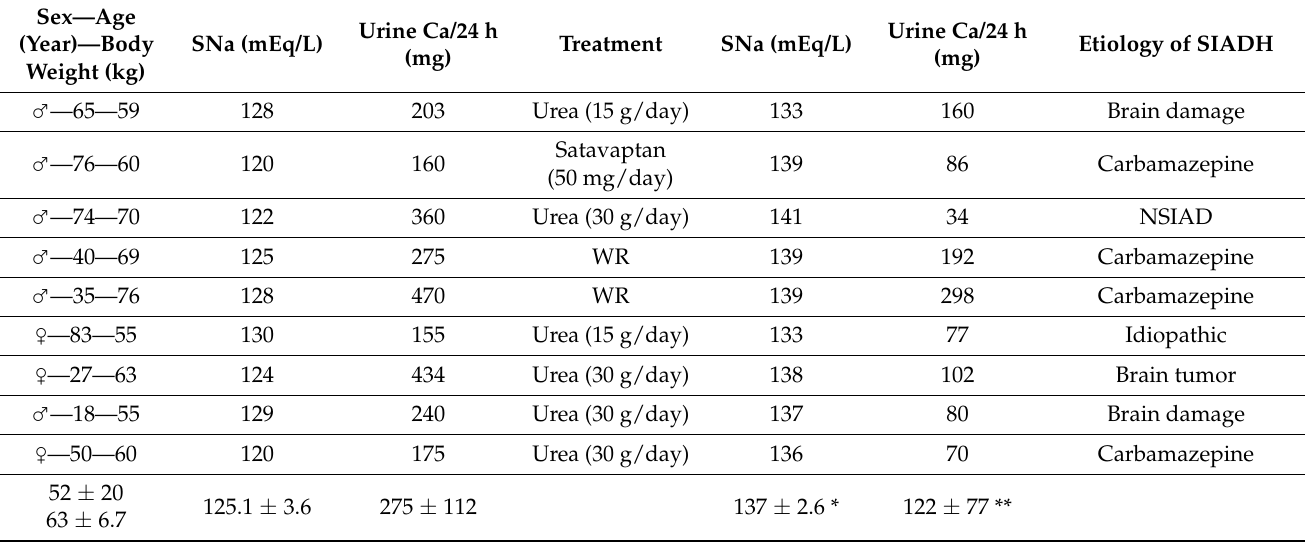
Table 3. Evolution of 24 h urine calcium excretion before and after normalization of serum sodium (SNa) in 9 patients with SIADH (data obtained after at least 2 weeks of